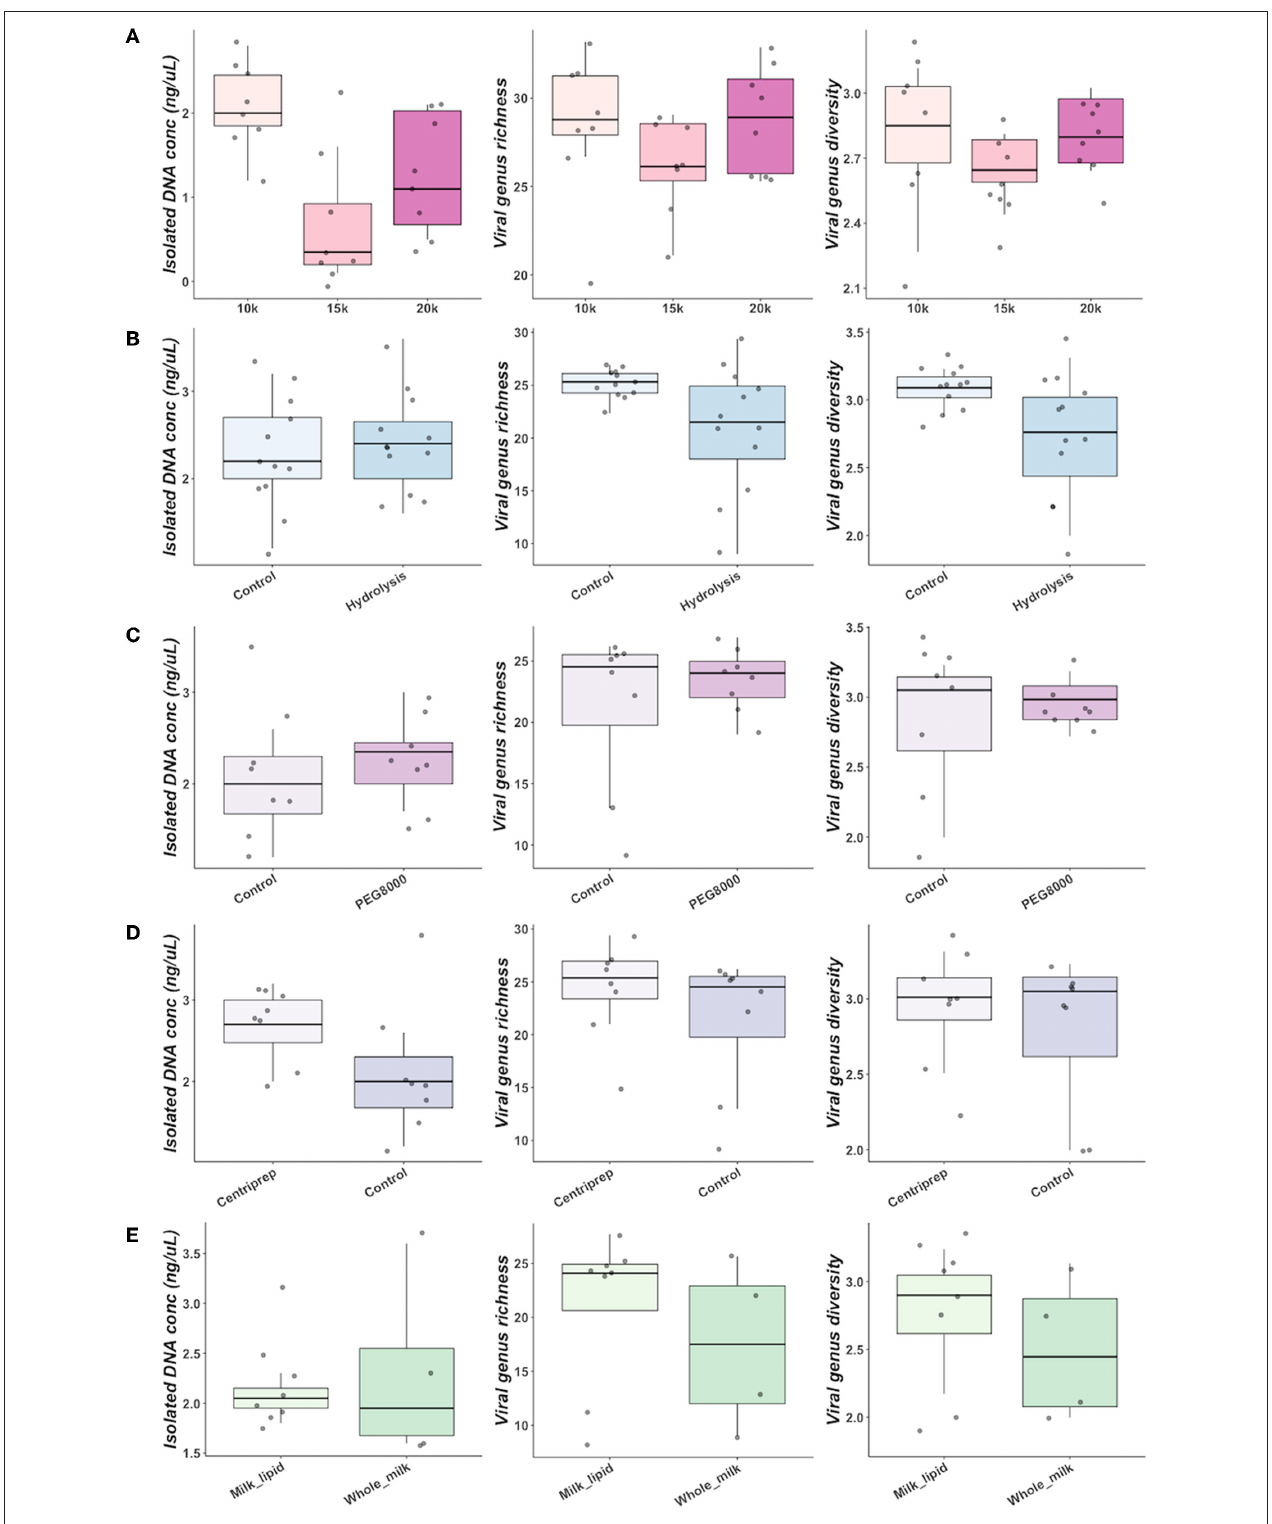
FIGURE 2 | Comparisons of DNA concentration, genus richness and Shannon diversity between centrifugal spin speeds for size-based separation (A) , addition of digestive enzymes for milk hydrolysis (B) , concentration of bacteriophage particles with PEG8000 (C) , filtration of bacteriophage with Centriprep devices (D) , and utilization of different milk fractions (E)